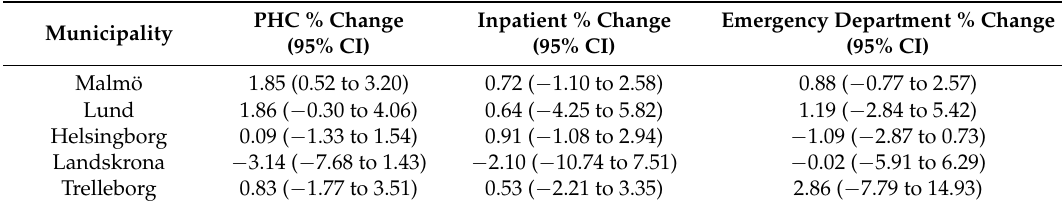
Table 3. Percent change in the number of visits to PHC clinics, inpatient admissions, and emergency department visits with 95% CI associated with a 10 µ g/m 3 increase in NO 2 lag 0–2 in five municipalities during 2005–2010 in multi-pollutant models.